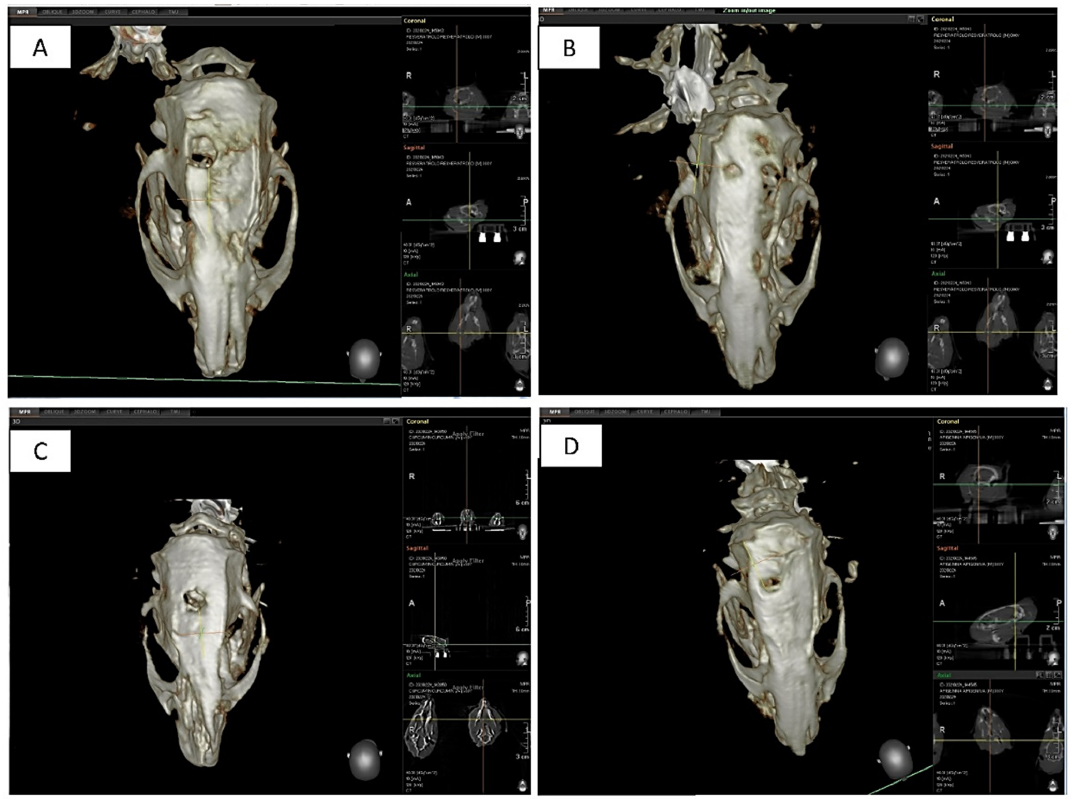
Figure 5. Details of the cone beam tomography scans of the specimens after 30 days of treatment. ( A ) Control no treatment after 30 days; ( B ) apigenin treatment with daily administration after 30 days; ( C ) curcumin treatment with daily administration after 30 days; ( D ) resveratrol treatment with daily administration after 30 days.